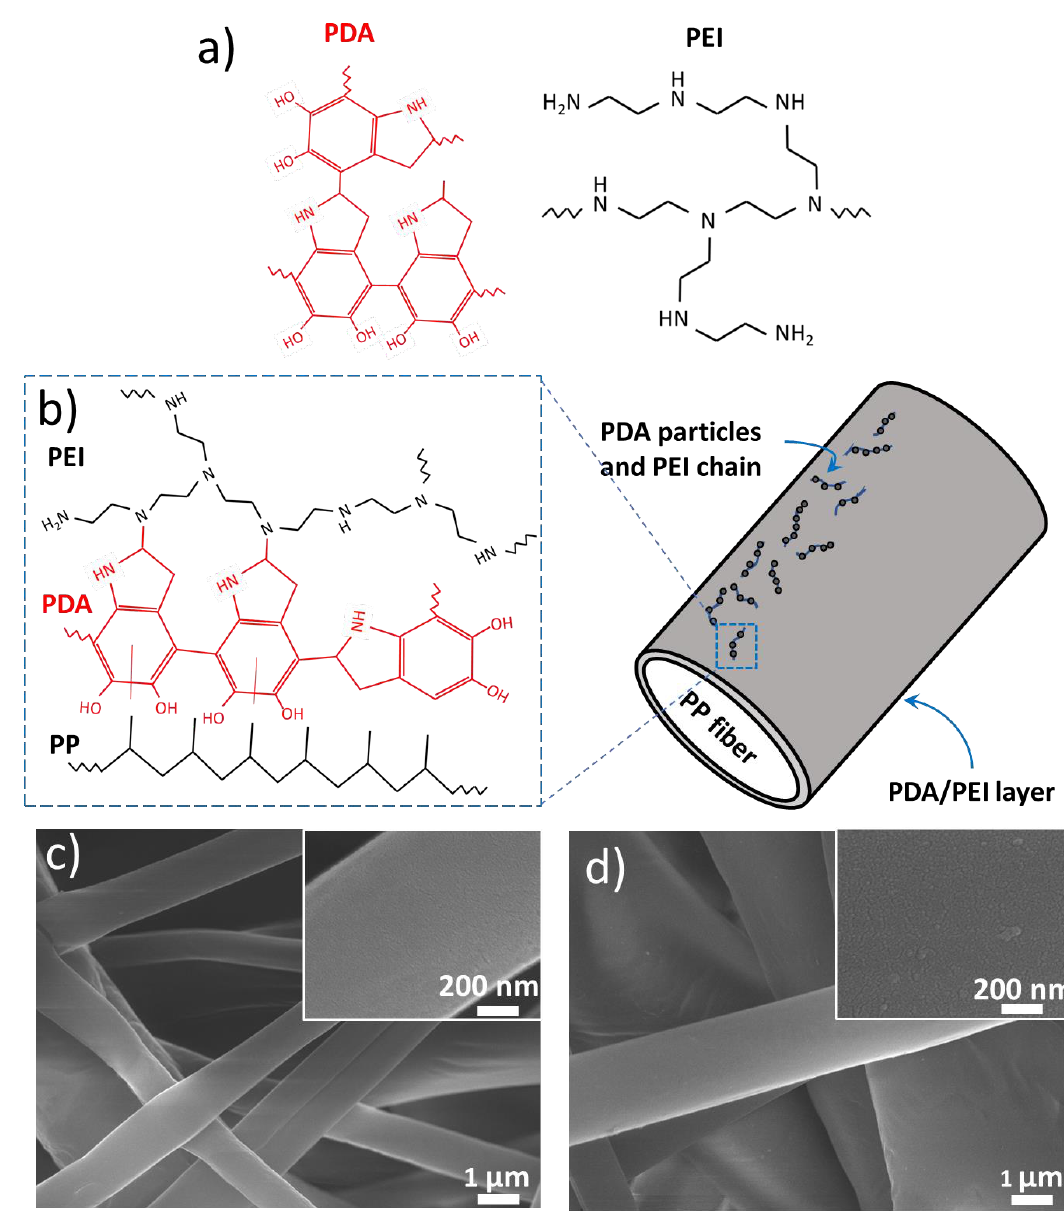
Figure 2. ( a ) The molecular structure of PEI and PDA. ( b ) Their chemical interaction to form PDA/PEI aggregates on the surface of PP fibers. ( c ) The top-view SEM image of PP fibers in pristine PPMM. ( d ) The top-view SEM image of PP fibers in functionalized PPMM. The insets are their respective high-magnification